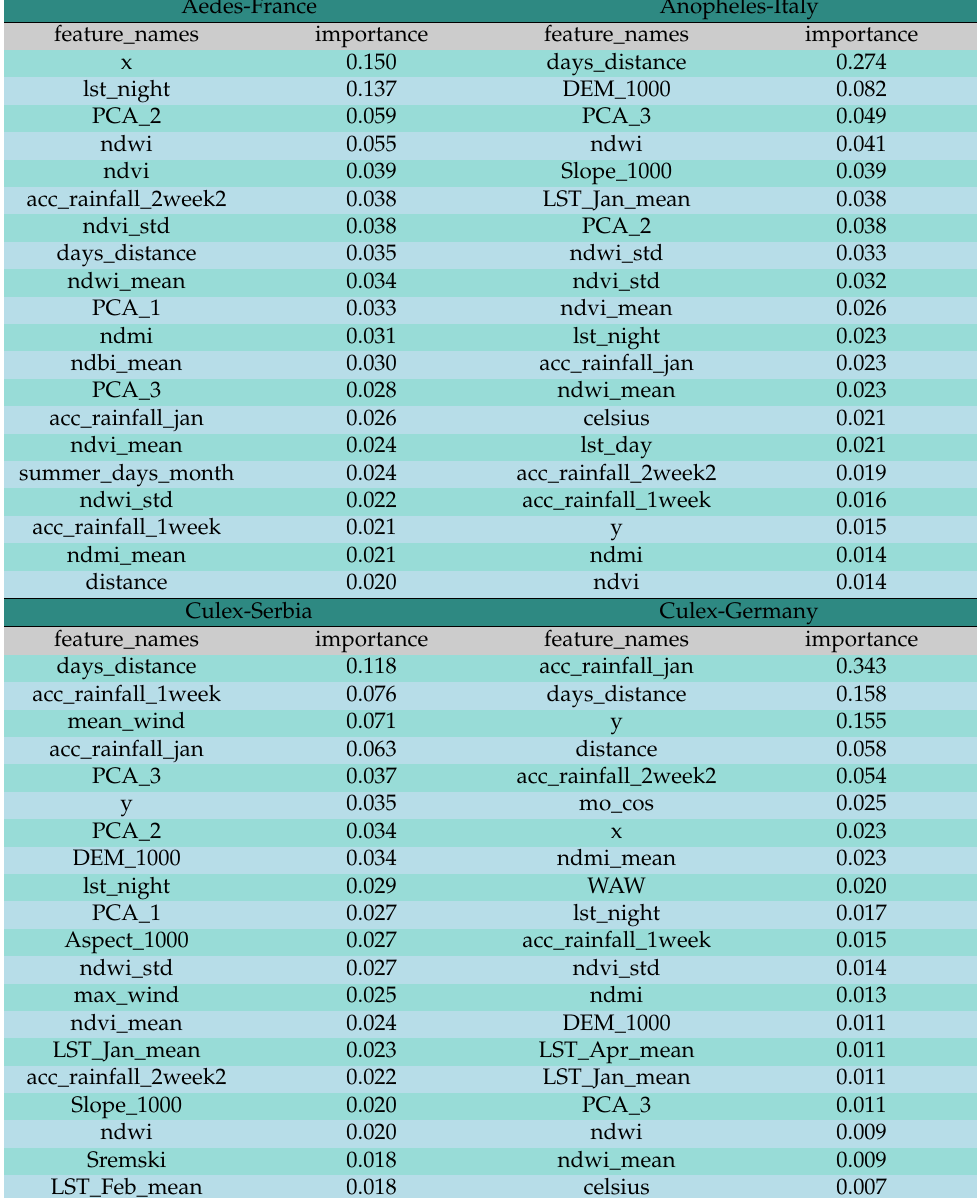
Table A5. Most important features per case using only EO